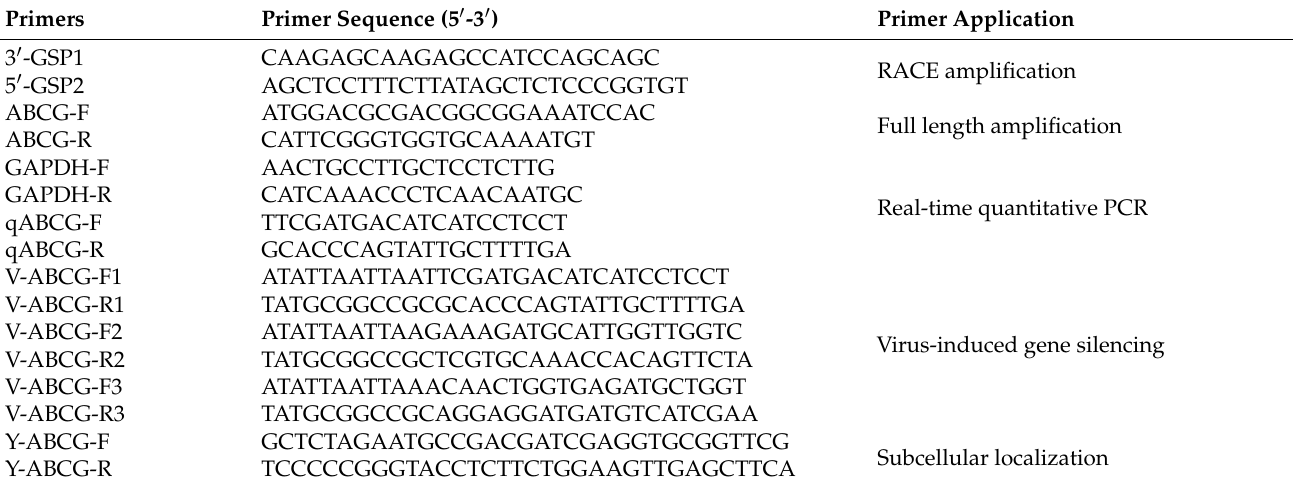
Table 1. Primers used for cloning, qRT-PCR, vector construction, and gene